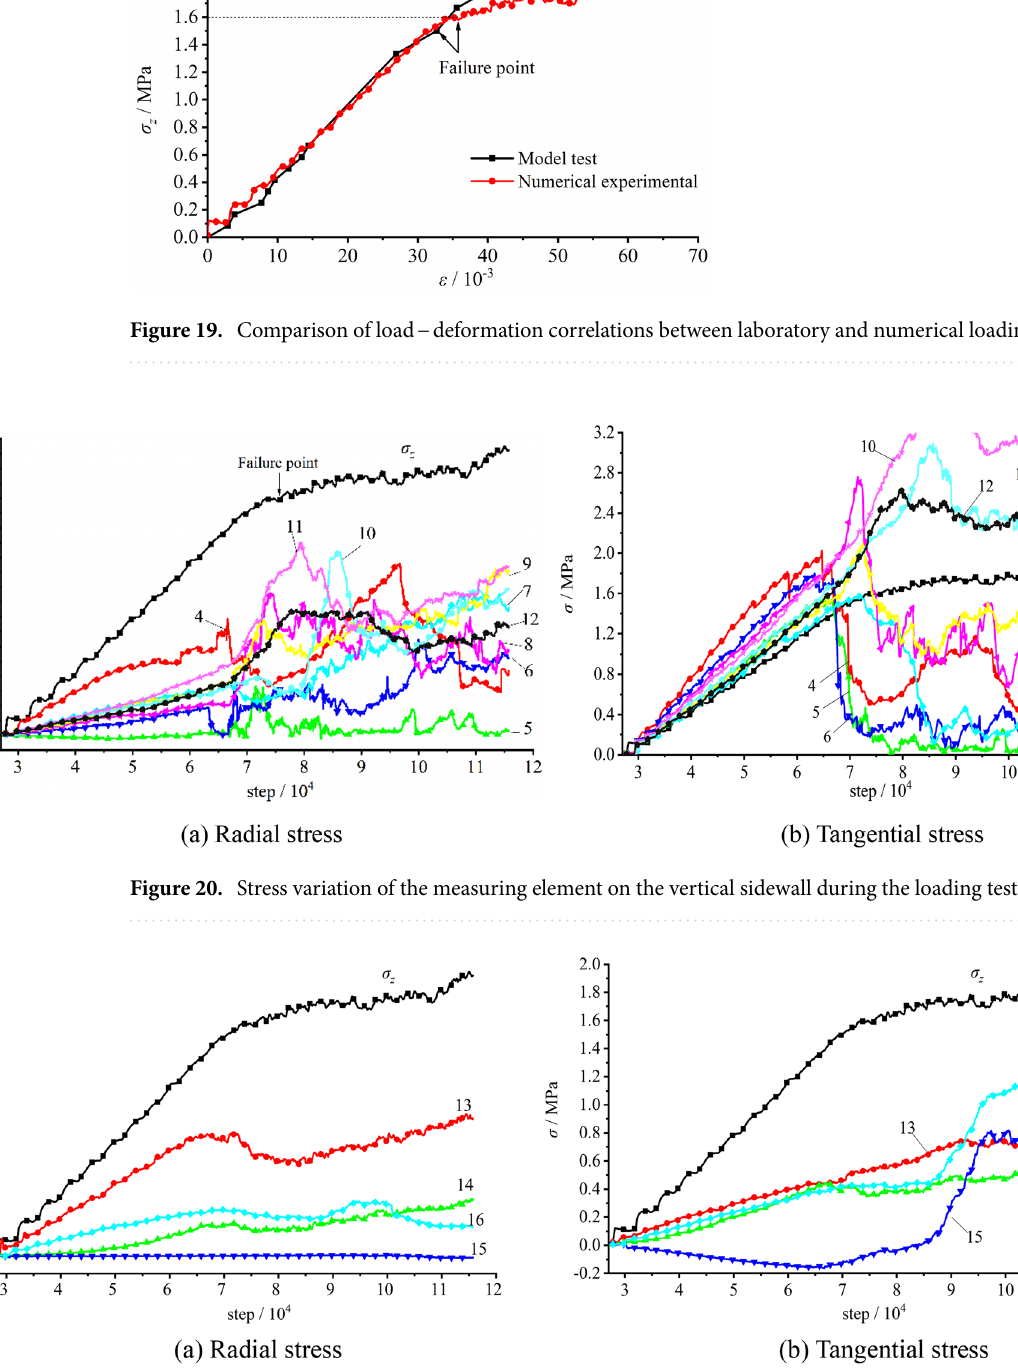
Figure 21. Stress variation of the measuring element at the arch crown and bottom during the loading